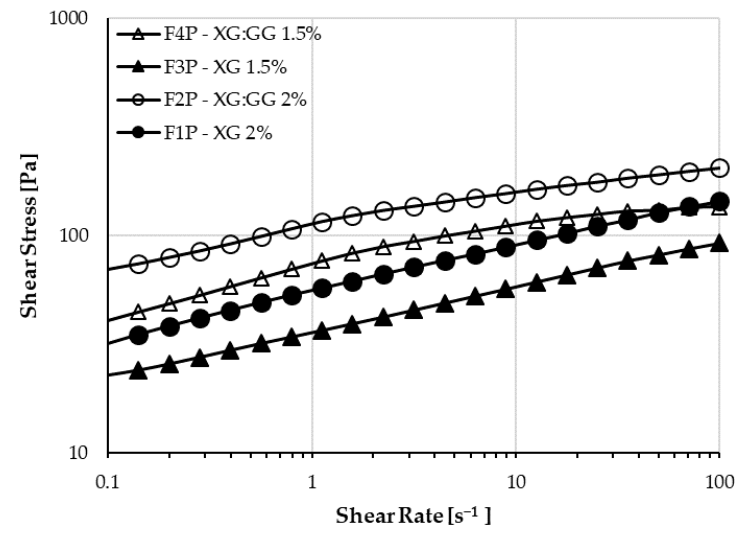
Figure 3. Plots of shear stresses versus shear rates of XG and XG:GG mixtures. Table 4. Viscosity values and injection force measurements of each